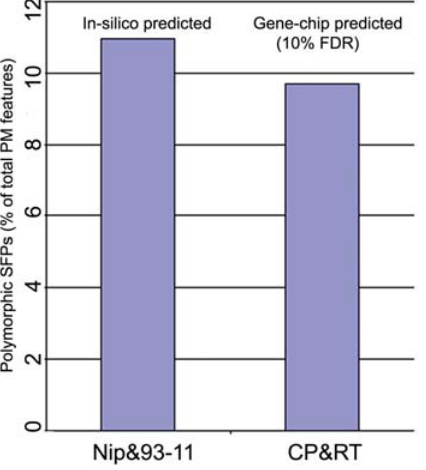
Figure 4. Polymorphic features predicted by in-silico analyses and gene- chip experiments. NIP=Nipponbare; CP=Cypress; RT=RT0034 and PM=perfect match.